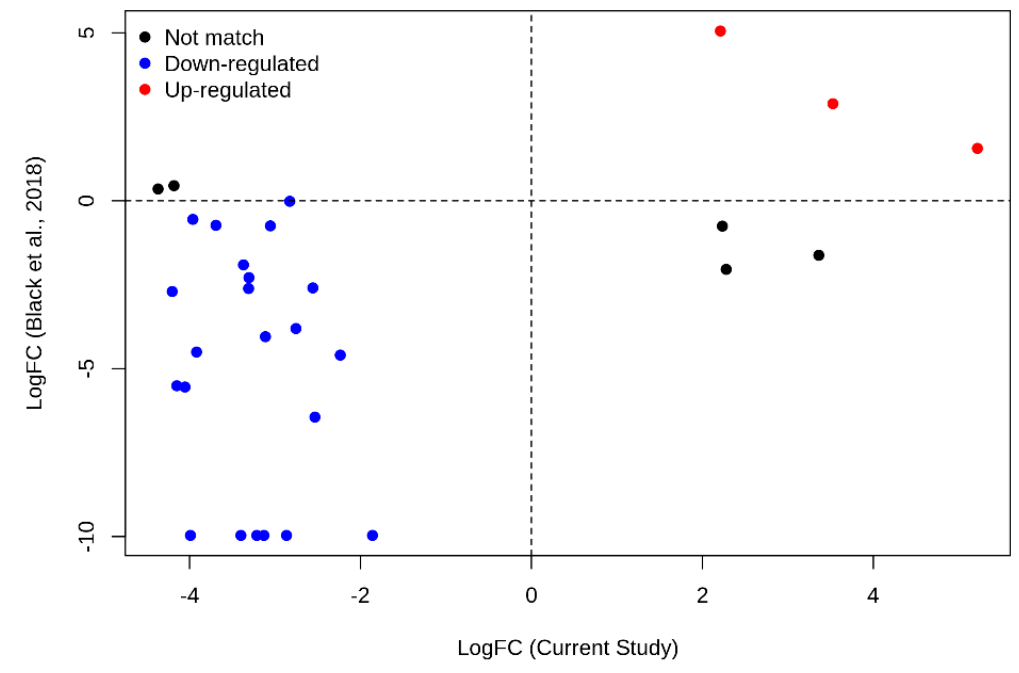
Figure 3. In–silico validation using PRJNA475681. Scatter plot showing the expression trend (i.e., logFC) of the 30 lncRNAs found in the current study compared with the Bioproject PRJNA475681 (childhood B-ALL RNA-Seq dataset by Black et al. [50], 2018). The values relative to lncRNAs scored down-regulated and up-regulated in both studies are highlighted in blue and red, respectively; instead, values relative to lncRNA with the opposite trend in the two studies are highlighted in black.